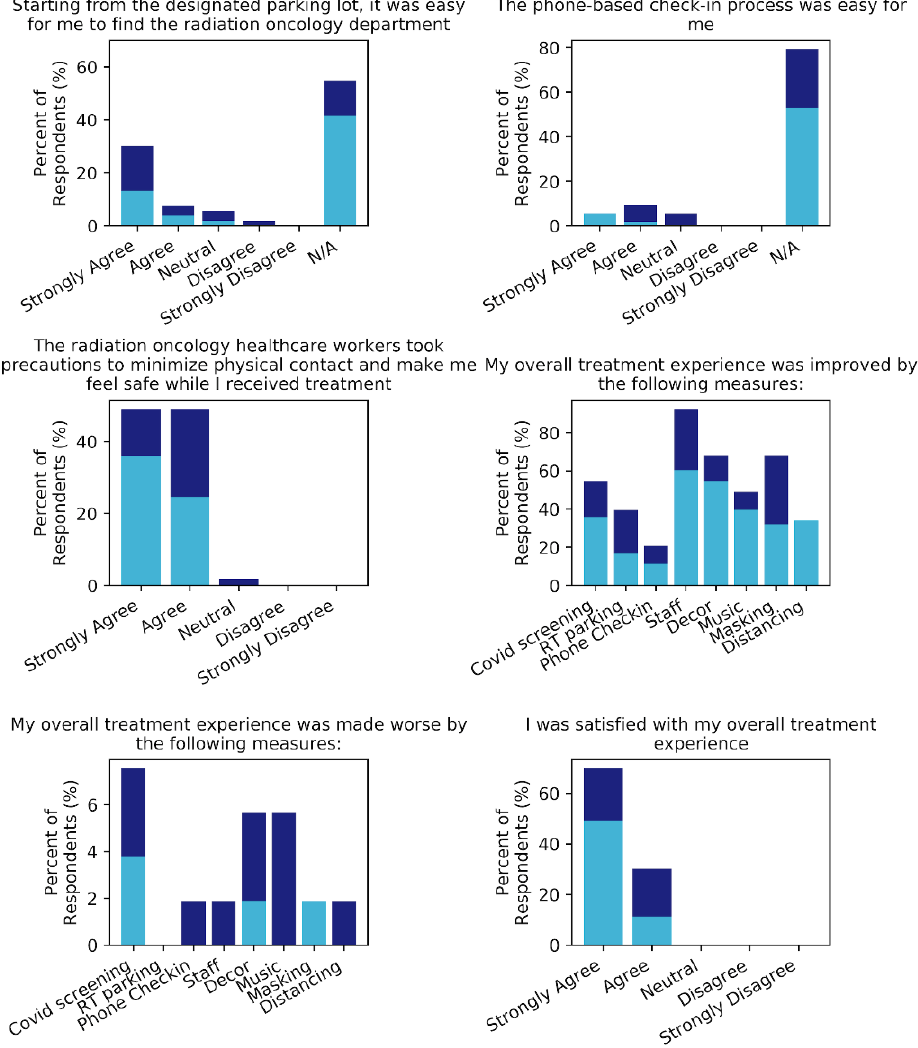
Figure 3. Responses to questions about patient satisfaction with treatment appointments and overall patient experience. Online responses are shown in indigo and phone in sky blue.